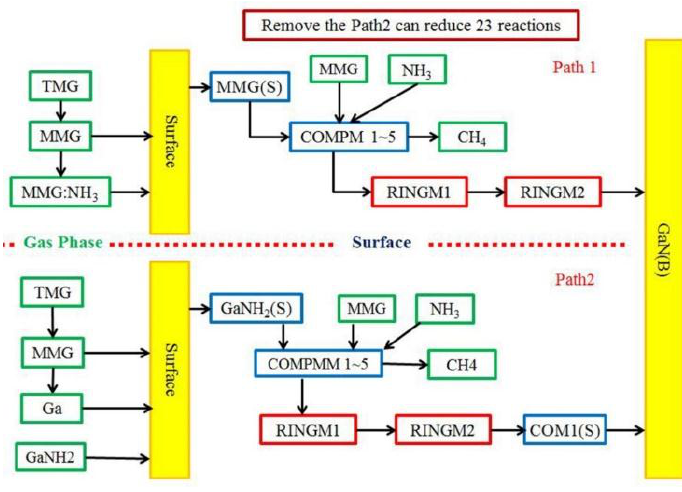
Figure 5. Schematic for Paths 1 and 2.